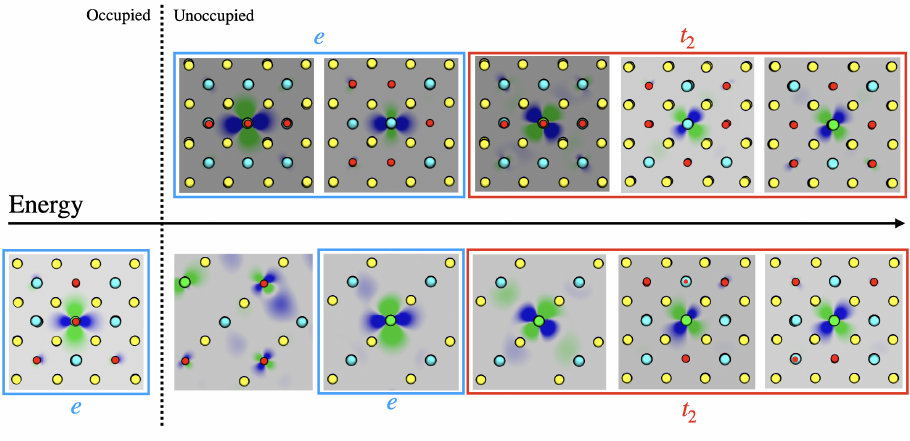
Figure A4. 3 d orbitals in configuration α 1 (top row) and configuration β 1 (bottom row). Yellow circles = sulfur, red circles = copper, blue circles = aluminium and green circles = iron.